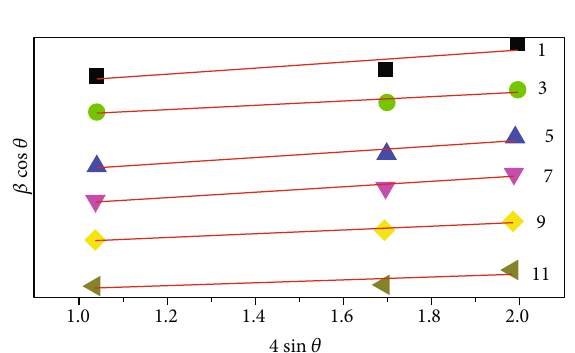
Figure 2: W – H plots of as-formed ZrO